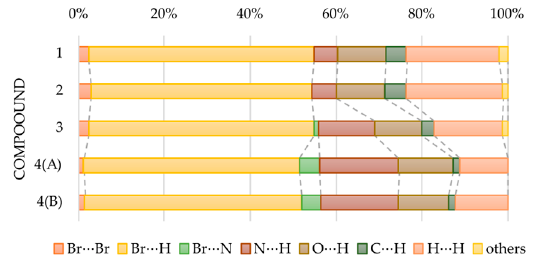
Figure 4. Relative contributions to the Hirshfeld surface area of the overall close molecular contacts for the complex anions in 1 – 4 .